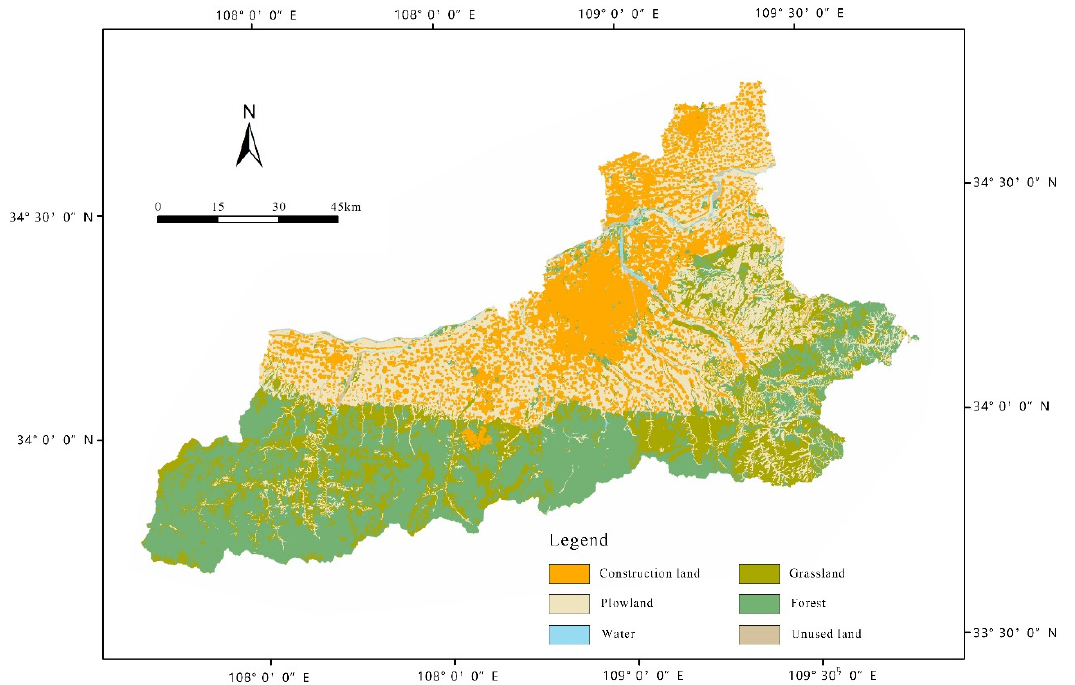
Figure 8. Simulation diagram of land scope for urban construction in 2030.